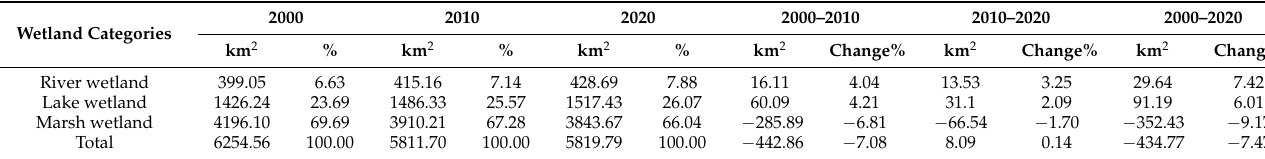
Table 6. Classification accuracy of wetlands in the YRSNP. Table 6. Wetland area change in the TRSNP from 2000 to 2020.